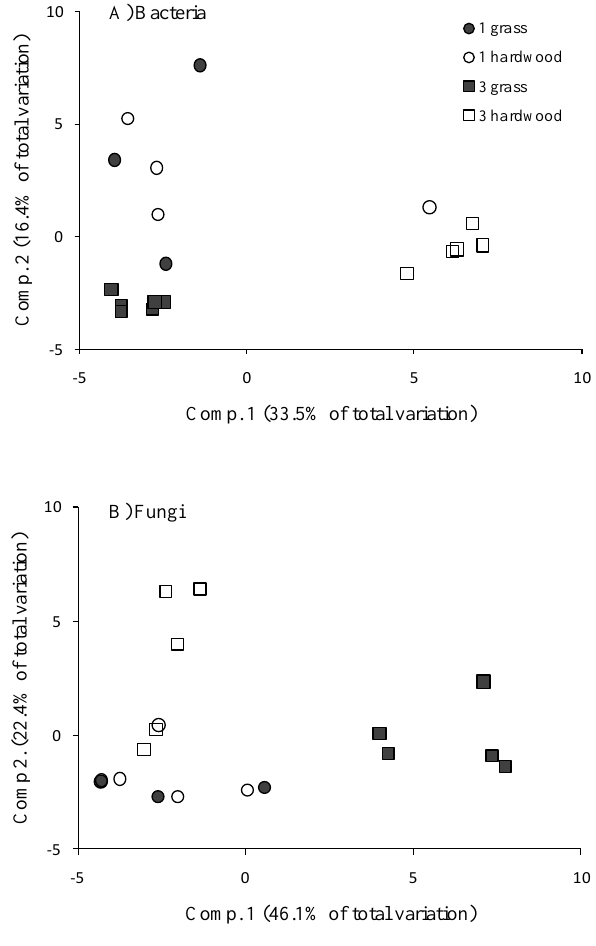
Fig. 3. Principle components plots of bacterial (A) and fungal (B) communities, using Euclidean distance (calculated from phylotype abundances), for inocula in round 1 (circles) or round 3 (squares). The phylogenetic composition of these inocula cluster by litter en- vironment (grass or hardwood) in round 3 only, following exposure to these litter environments in previous rounds (1 and 2).